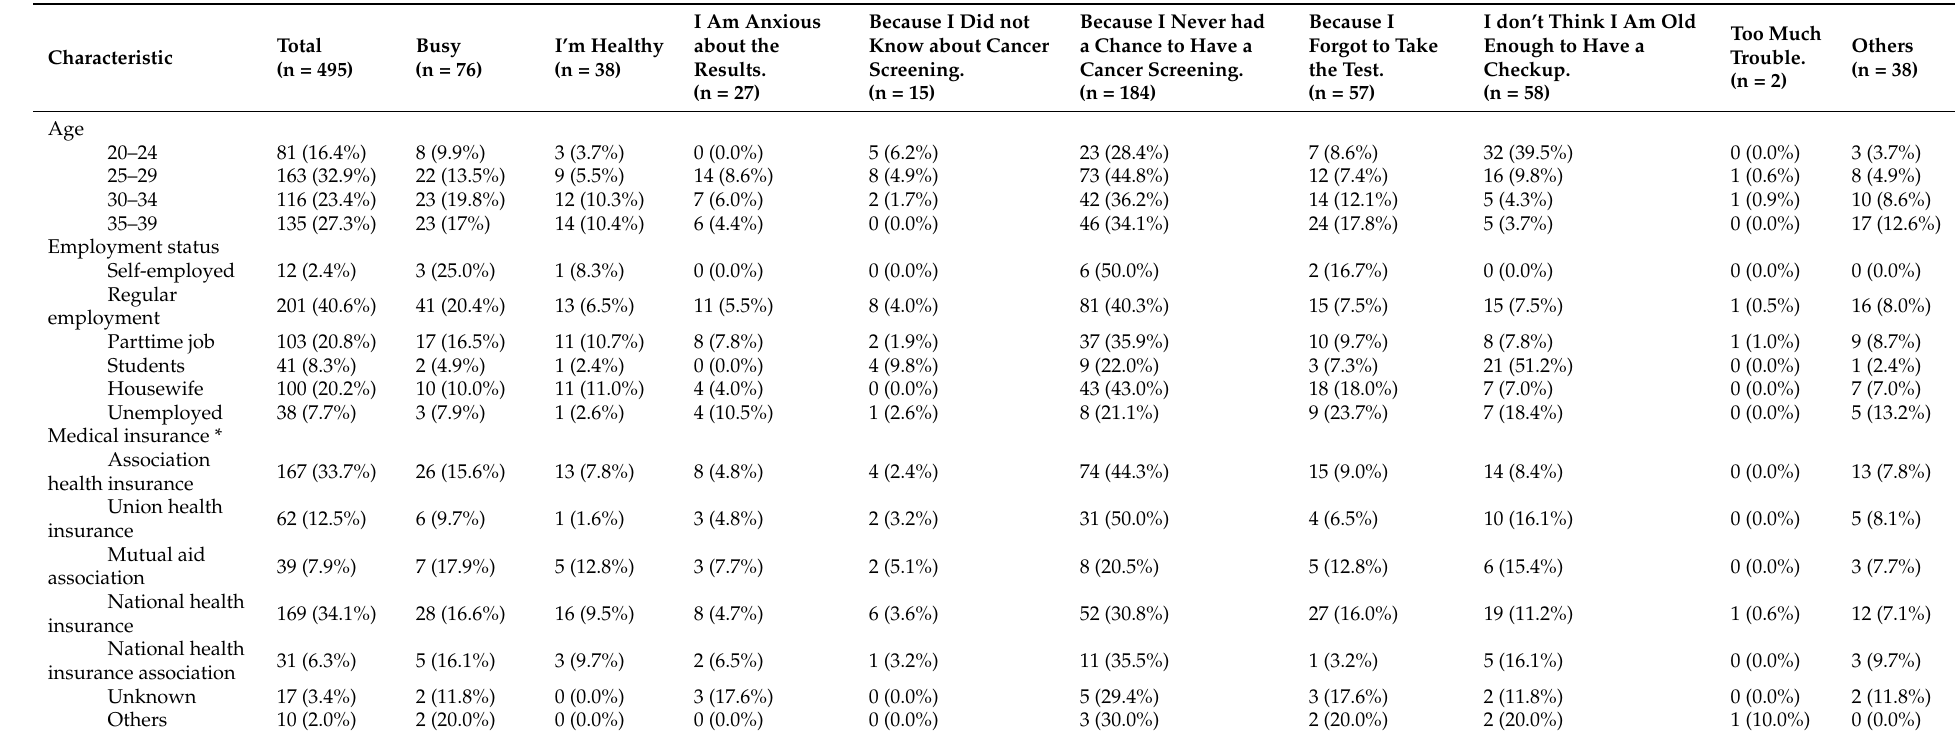
Table 3. Reasons for not participating in CCS by age, employment status, and medical